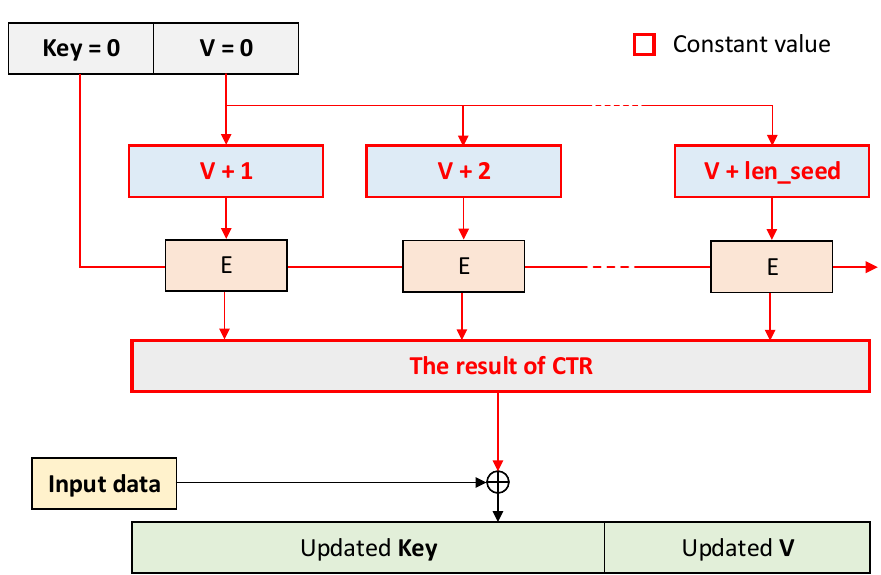
Figure 19. The part that can be constant value in the update